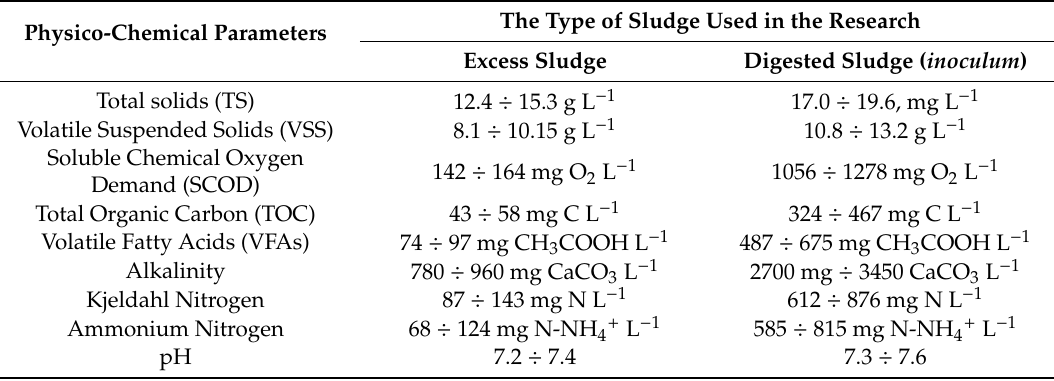
Table 1. General physico-chemical parameters of sludge used in research. Physico-Chemical